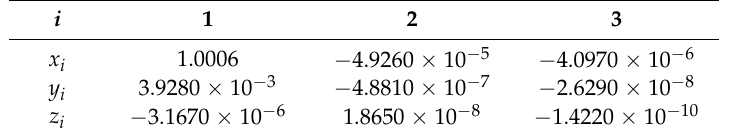
Table 1. Polynomial coefficient of the thermal expansion coefficient.